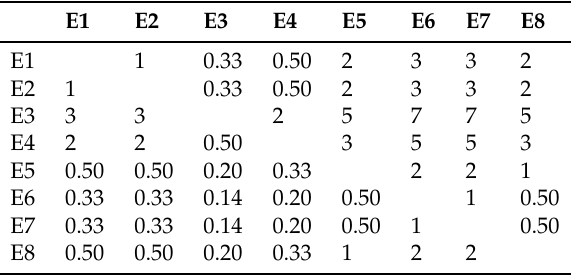
Table 8. AHP equipment matrix that shows the relative importance of the equipment.